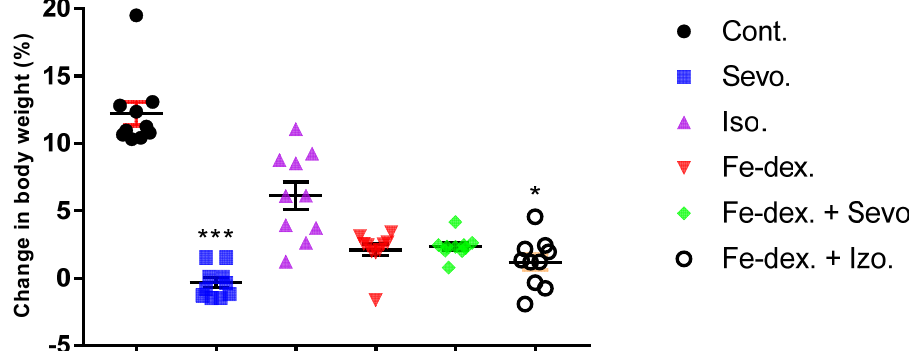
Figure 1. Dot plot of body weight change of rats treated with inhaled anesthetics, iron dextran, and their combination. Rats ( n = 10 per group) were treated with ip injection of iron dextran (50 mg/kg) and exposed to 2.4 vol % sevoflurane inhalation and 1.3 vol % isoflurane inhalation, and to a combination thereof where inhaled anesthetics were given 2 h after ip injection of iron dextran. Animals were treated every other day for 28 days. Each animal sample is indicated by a single dot. The results are expressed as the mean value of each experimental group ± SE. * Statistically significant compared to the control group (* p < 0.05; *** p < 0.001). Abbreviations: Cont., control group; Sevo., sevoflurane group; Iso., isoflurane group; Fe-dex., iron dextran group; Fe-dex. + Sevo., group treated with iron dextran and sevoflurane; and Fe-dex. + Iso., group treated with iron dextran and